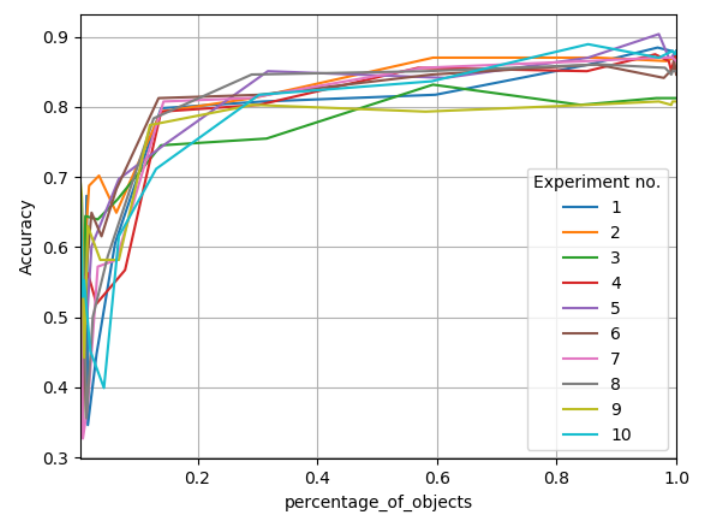
Figure 4. Visualization of classification efficiency for ten learning cycles of the neural network taking into account the percentage reduction of